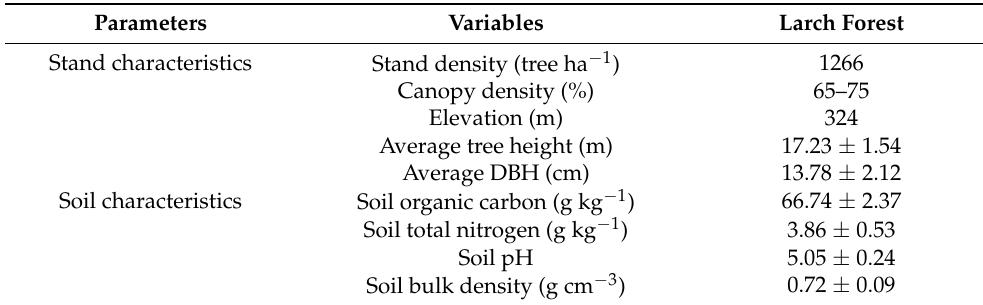
Table 1. The basic characteristics of the larch forest. The soil characteristics were shown in 0–10 cm soil layer. The values are followed by mean ±